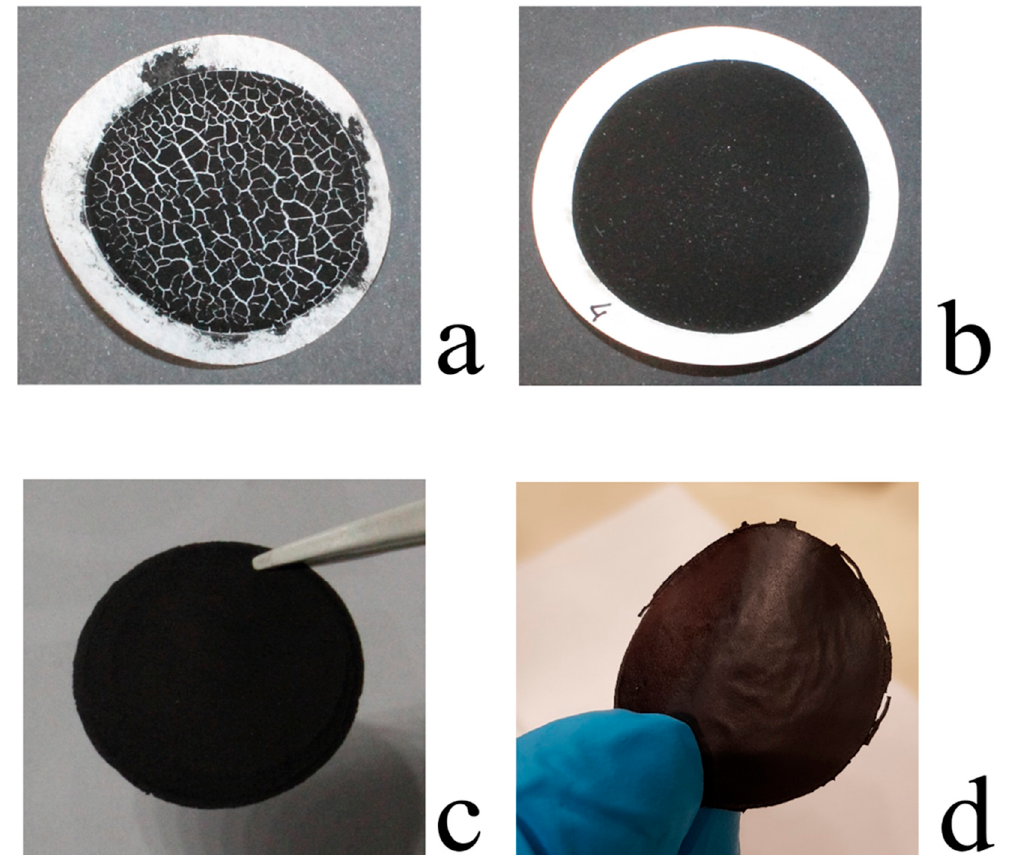
Figure 1. Appearance of buckypaper (BP) membranes under different experimental preparation procedures: ( a ) Brittle and un-detachable BP membrane filtered through a poly (vinylidene fluoride) (PVDF) membrane with reduced pore size; ( b ) whole and detachable; ( c ) free-standing and ( d ) flexible BP membrane obtained under the optimal conditions reported in the Experimental section. Table 1. Physical-chemical properties of BPs.